Question: How would you classify this visualization?
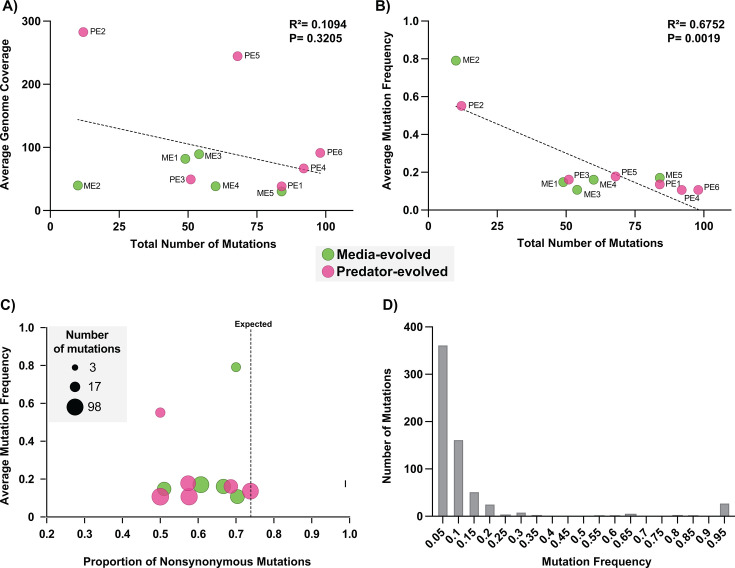
Answer: scatter